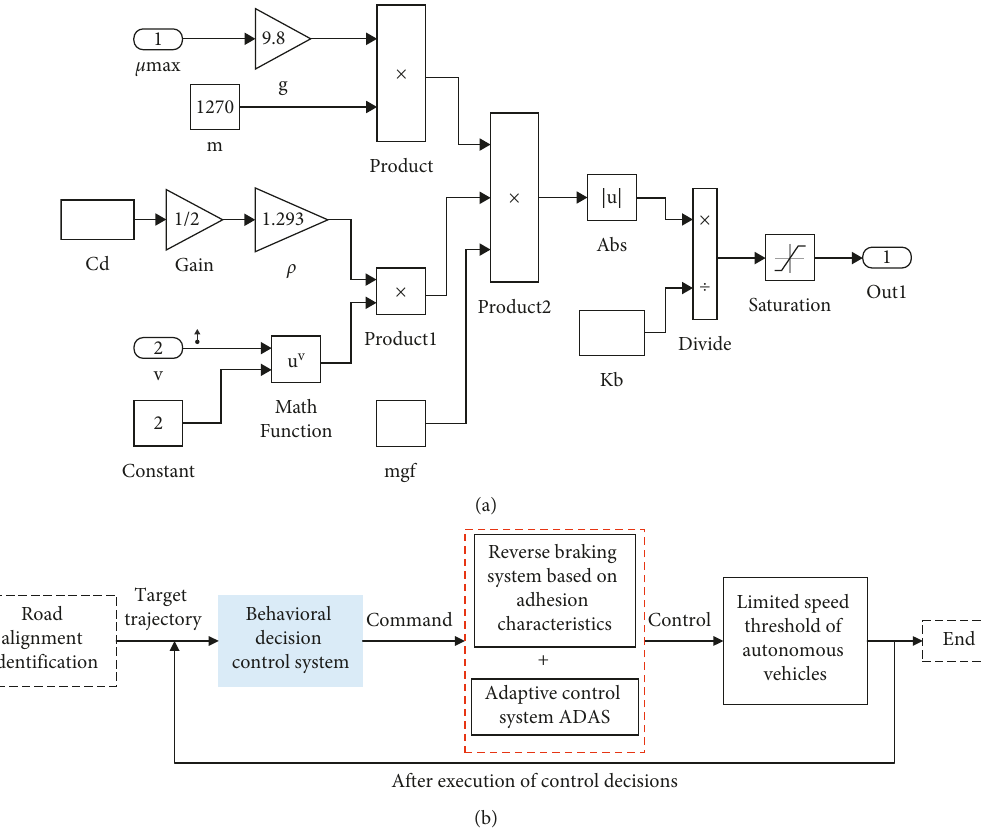
Figure 5: Braking system of autonomous vehicles: (a) reverse brake control algorithm based on MATLAB/Simulink; (b) schematic diagram for steering braking control